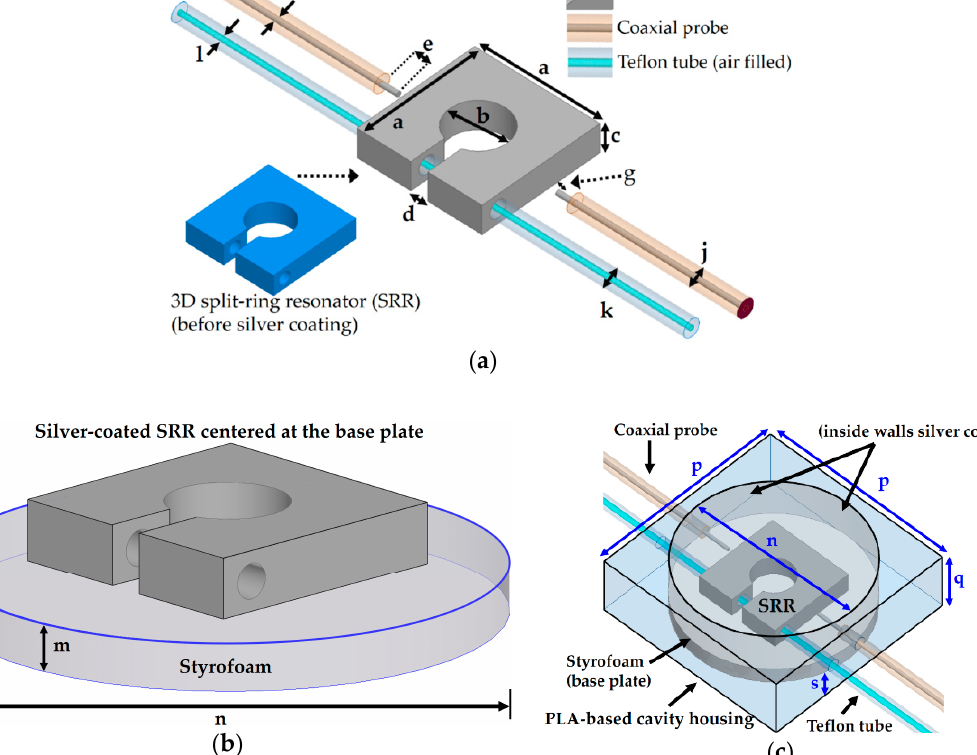
Figure 1. Design parameters of the final layout of the proposed microwave chemical sensor: ( a ) Silver-coated 3D split-ring resonator (SRR) and capacitively coupled coaxial probes, ( b ) SRR centered on the base plate (Styrofoam), and ( c ) silver-coated 3D SRR residing in a cavity housing and capacitively coupled through two coaxial cables.